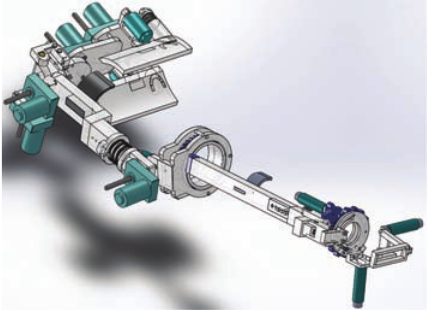
Figure 1: Total exoskeleton system.